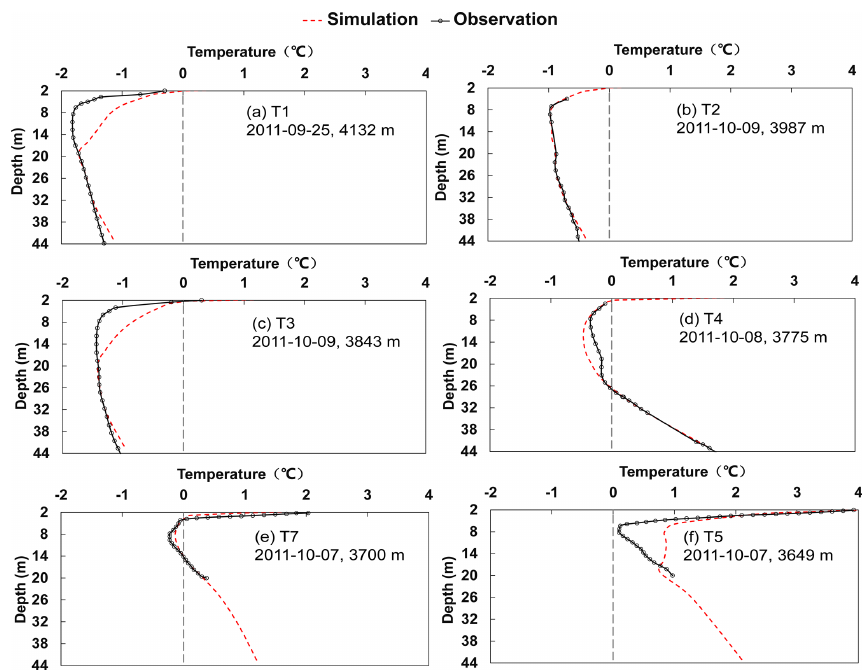
Figure 3. Comparison of the simulated and the observed soil temperature at borehole observation sites, with the observed data provided by Wang et al.